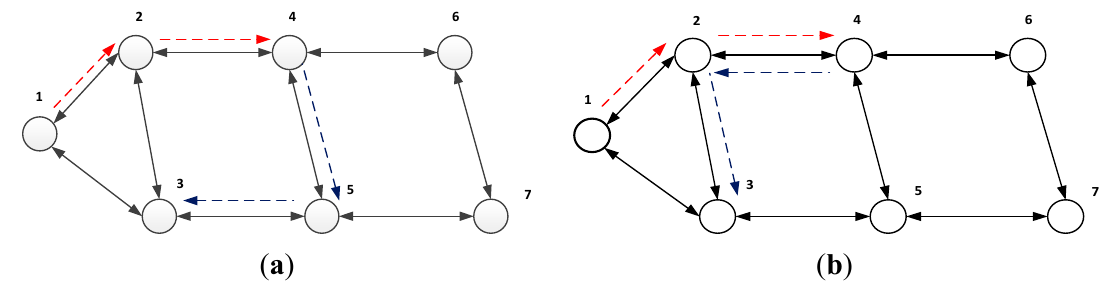
Figure 2. ( a ) Routing without coding consideration; ( b ) Routing with coding consideration at node